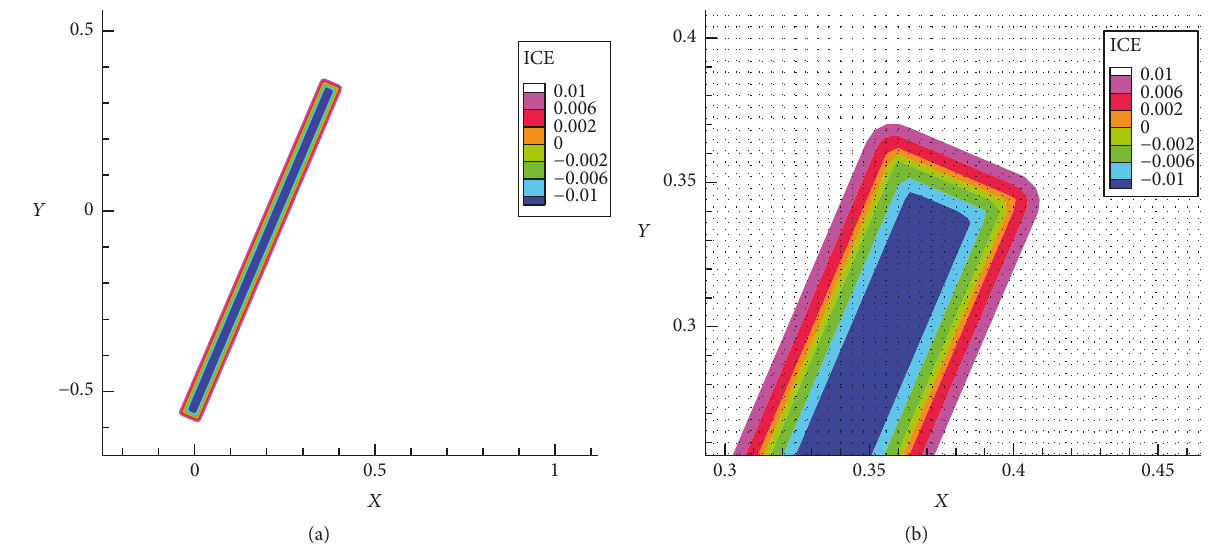
Figure 1: Global level set function of one rigid body (rectangular plate) onto a Cartesian